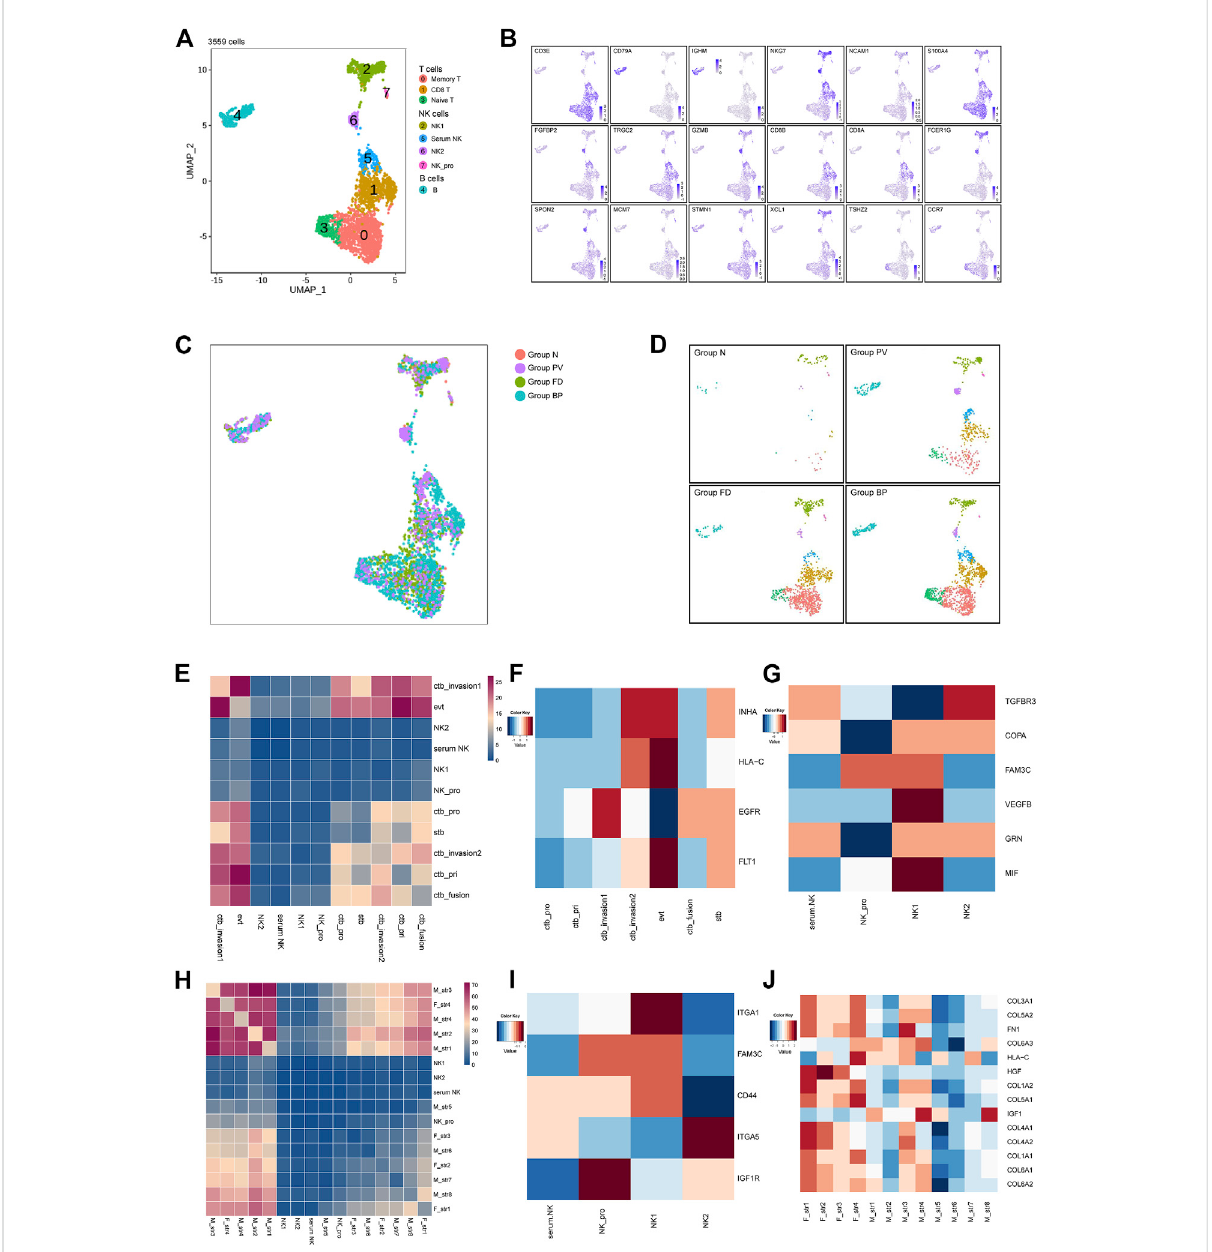
FIGURE 6 Other immune cells at the maternal-fetal interface for the placenta with PAS. (A) UMAP plot showing reclustering of immune cells of PAS placenta. (B) UMAP feature plots showing representative marker genes for the cell subtypes shown in Panel 6A. (C,D) UMAP plot of other immune cells colored by tissue of origin in the four groups. (I) . Split UAMPs displaying other immune subtypes by the origin tissues. (E,H) Total number of interactions betweenimmune cells and trophoblasts and stromal subtypes. (F – J) Expressionlevels of ligand ‒ receptor pairs. The scale isshown beside the